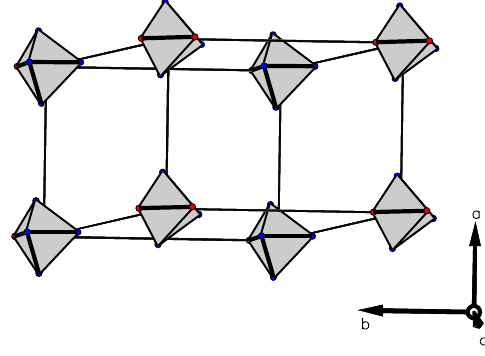
Figure 8. Supramolecular Boxes.